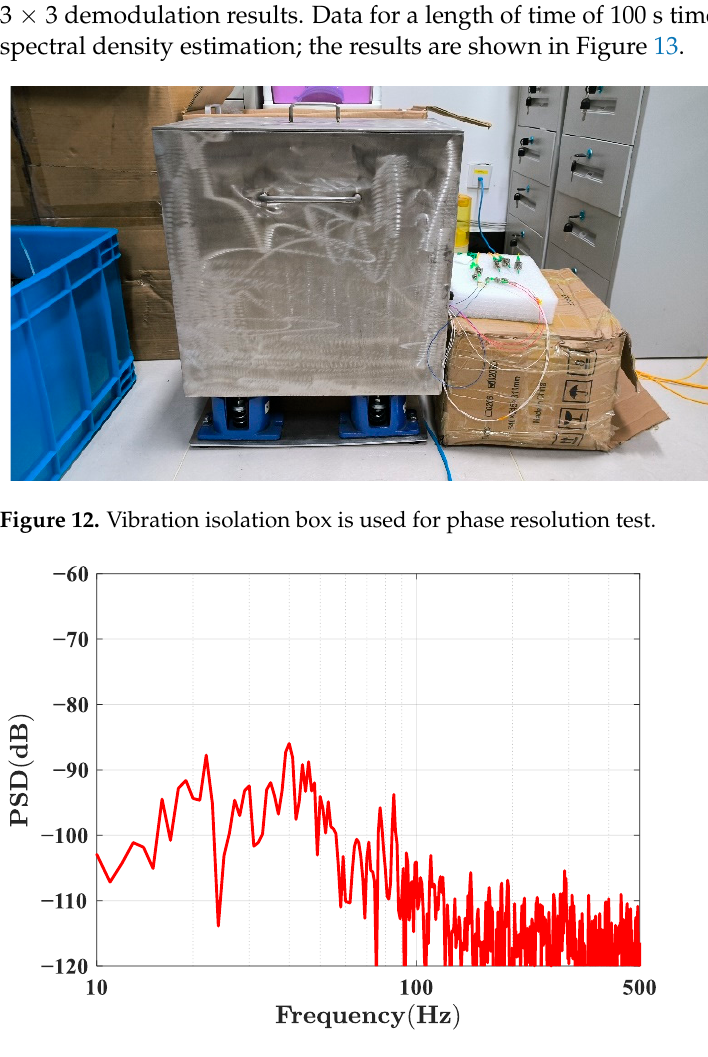
Figure 13. The phase power spectral density